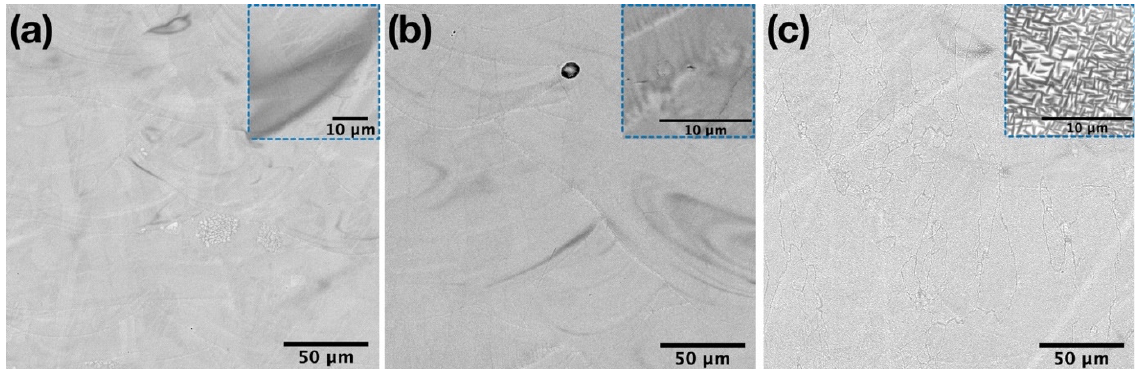
Figure 6. Microstructures of the samples fabricated from the Ti 2 AlNb-CYB powder at ( a ) 300 °C, ( b ) 700 °C, and ( c ) 850 °C substrate preheating temperature. Insets show microstructures of the corre- ( b ) 700 ◦ C, and ( c ) 850 ◦ C substrate preheating temperature. Insets show microstructures of the sponding samples at higher magnifications. corresponding samples at higher